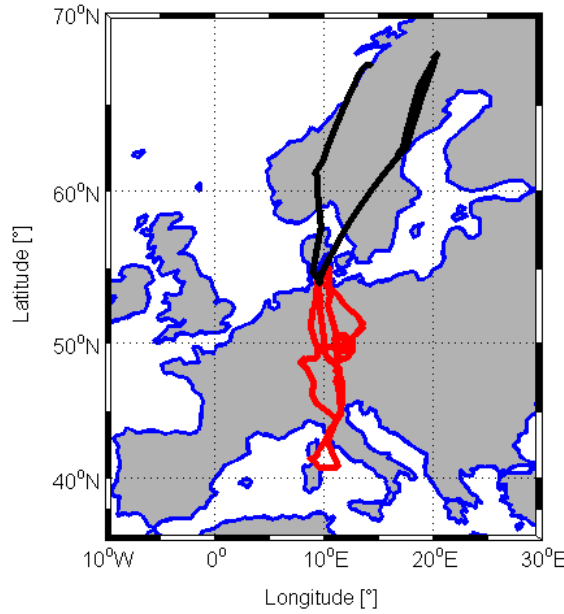
Fig. 3. Northern (black) and southern (red) flight tracks of the HOOVER 2 campaign.